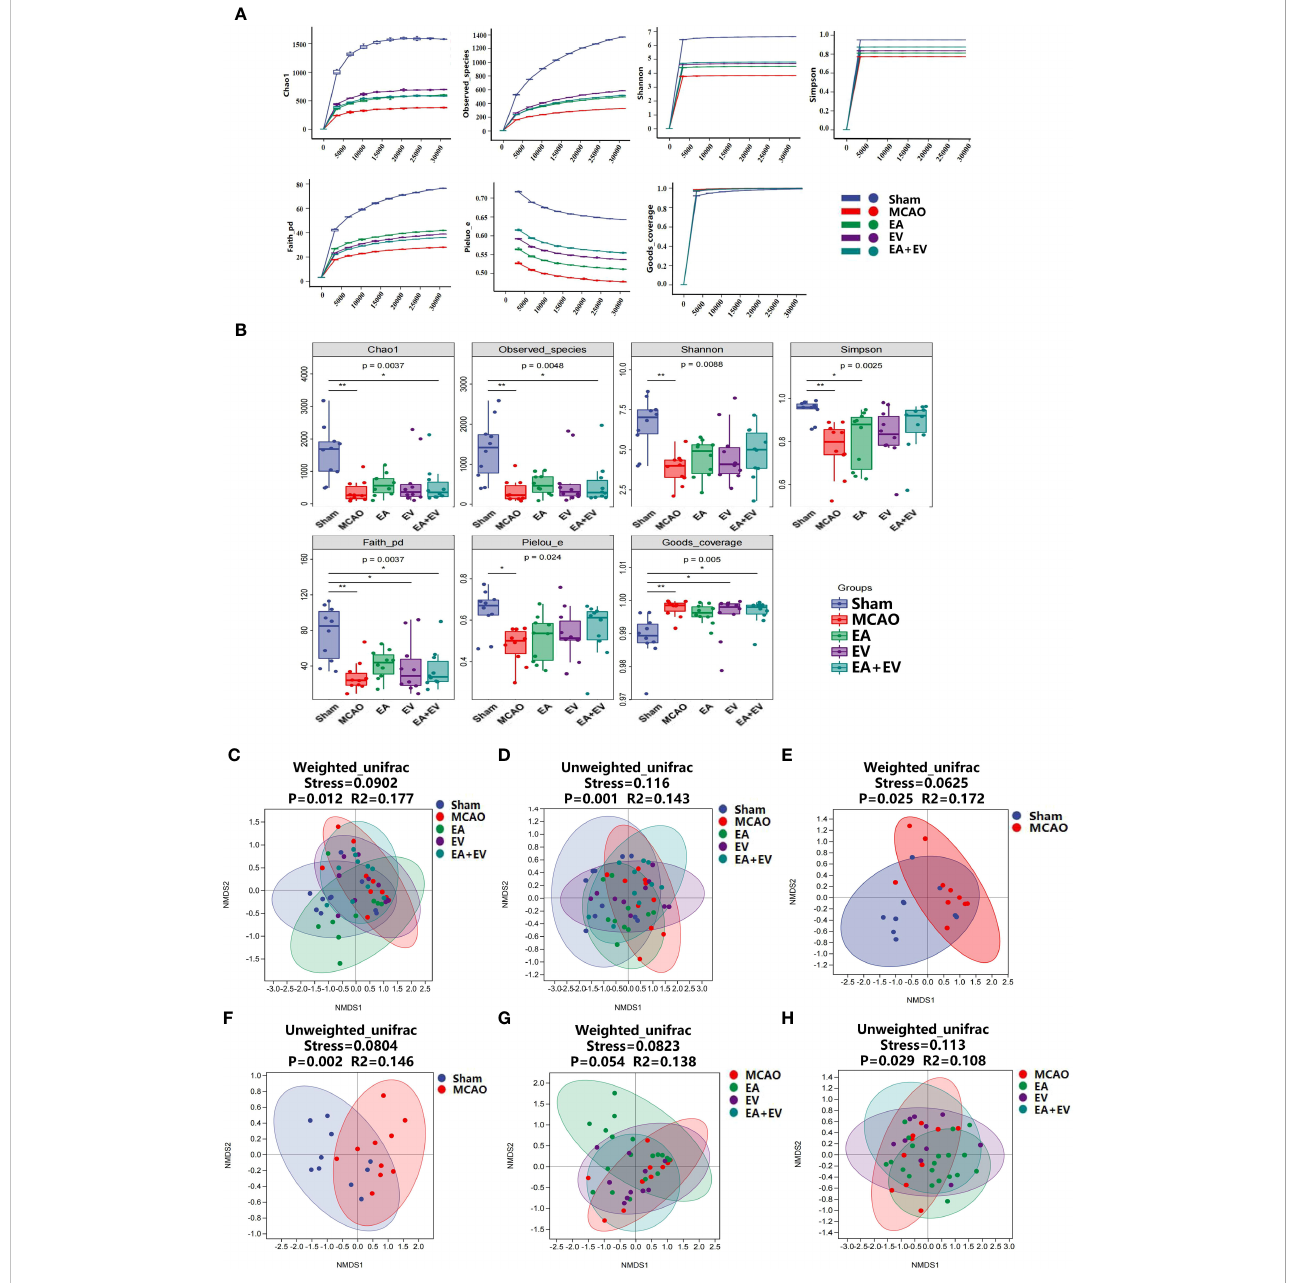
FIGURE 5 EA and iPSC-EVs treatments regulated the microbiota alpha and beta diversity after cerebral ischemia − reperfusion. (A, B) Alpha diversity of microbial communities (Chao1, observed species index for richness; Shannon and Simpson index table characteristic diversity; Faith ’ s PD index represents diversity based on evolution. Pielou ’ s evenness index was used to characterize the evenness. Good ’ s coverage index represents the coverage). (C – H) Nonmetric multidimensional scaling analysis (NMDS) of beta diversity in microbial communities (weighted unifrac, unweighted unifrac). NMDS simpli fi es the data structure by reducing the dimension of the sample distance matrix to describe the distribution characteristics of samples at a speci fi c distance scale. The lower the stress value of the NMDS, the better. The NMDS analysis results are more reliable when the stress value is less than 0.2, n =10/group, data were expressed as the mean±SD, * P <0.05, ** P <